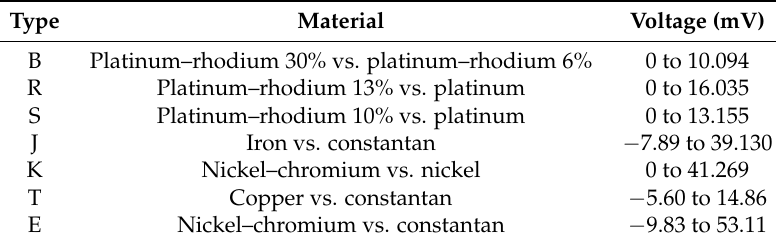
Table 3. Classification of thermocouples according to the voltage